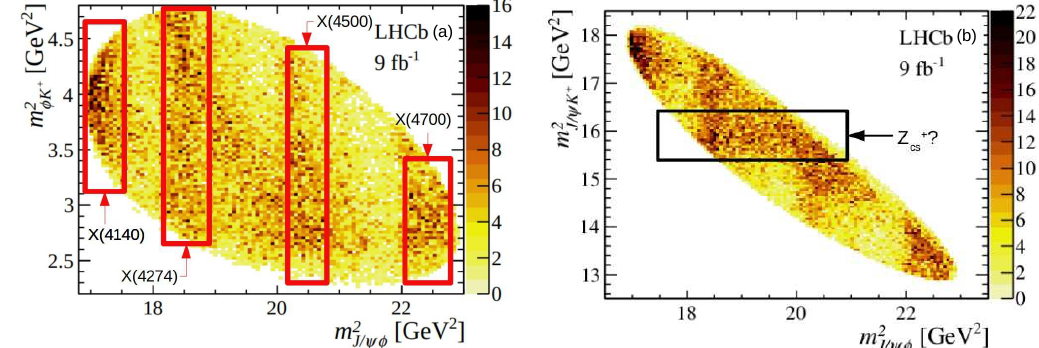
Figure 2: (a) The Dalitz plot of the J /ψφ squared mass against the φ K + squared mass. The bands corresponding to the X structures are highlighted. (b) The Dalitz plot of the J /ψφ squared mass against the J /ψ K + squared mass. A band which could possibly come from a Z + structure is cs